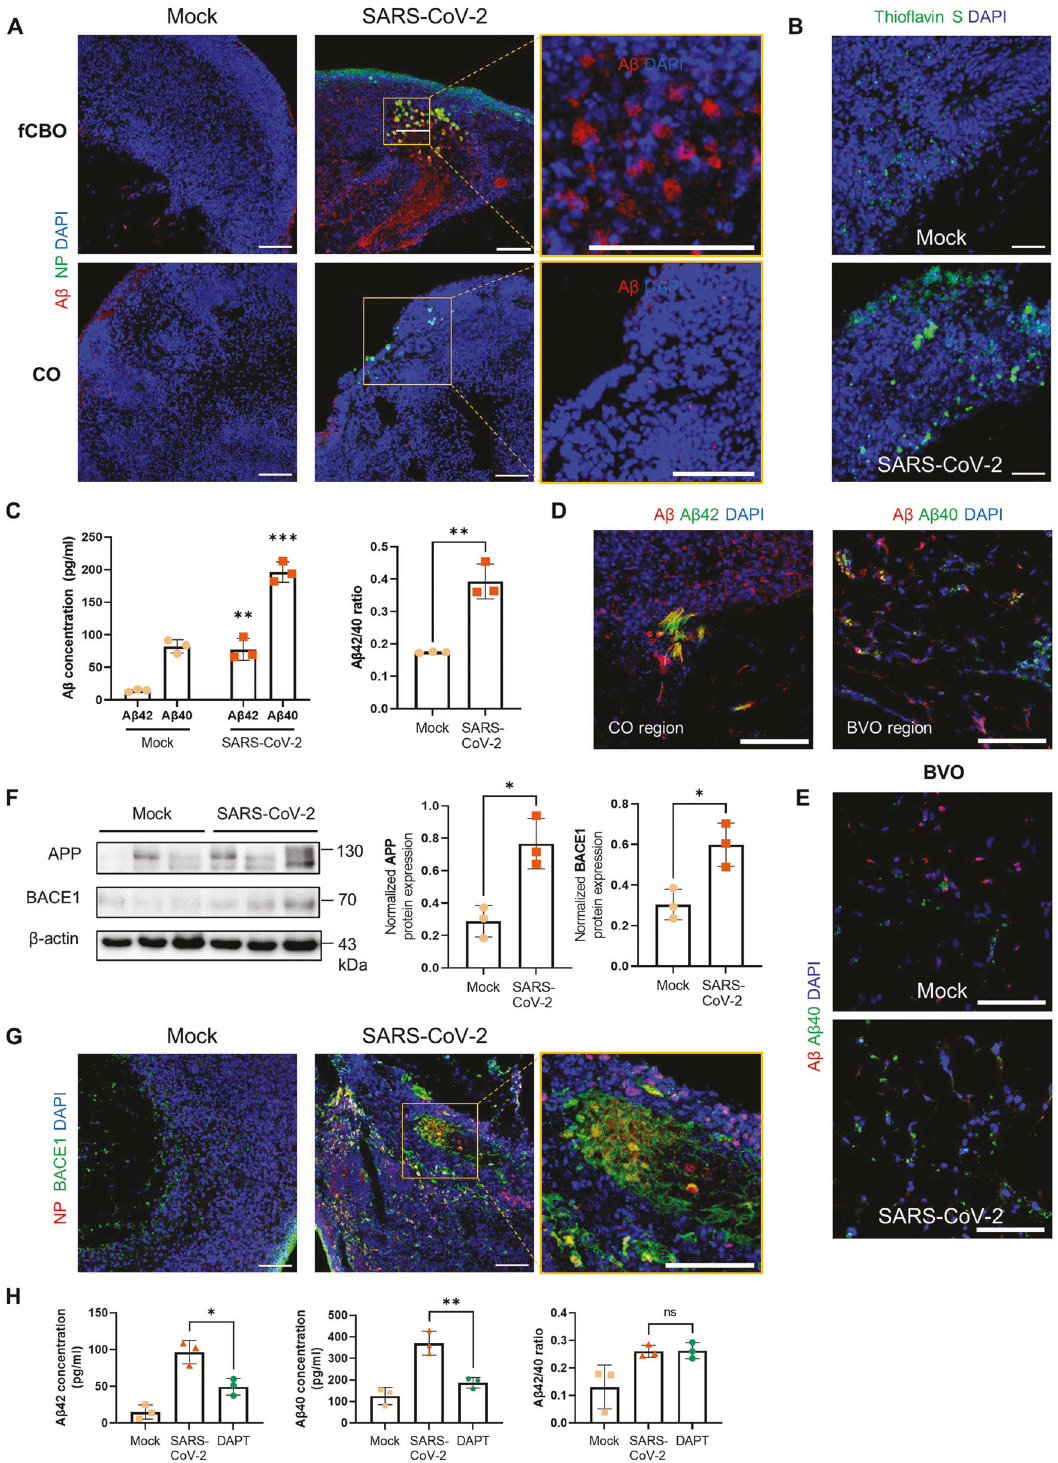
Fig. 5 SARS-CoV-2 infected fused cortical-blood vessel organoids expressed β -amyloid plaques. A Immunostaining of SARS-CoV-2 or mock infected fCBOs and COs for NP and A β . Scale bars = 100 μ m. B Thio fl avin-S staining of SARS-CoV-2 or mock infected fCBOs. Scale bars = 100 μ m. C Concentrations of A β 42 and A β 40 quanti fi ed by ELISA and A β peptide 42/40 ratios in fCBOs before and after SARS-CoV-2 infection ( n = 3). D Immunostaining of SARS-CoV-2 infected fCBOs for A β and 42-residue A β (A β 42) or 40-residue A β (A β 40). Cortical organoid region (left) and blood vessel organoid region (right). Scale bars = 100 μ m. E Immunostaining of SARS-CoV-2 or mock infected BVOs for A β and A β 40. Scale bars = 50 μ m. F Western blot for β -amyloid precursor protein (APP), β -secretase (BACE1) and the loading control β -actin of SARS-CoV-2 or mock infected fCBOs and relative protein levels. ( n = 3). G Immunostaining of SARS-CoV-2 or mock infected fCBOs for BACE1 and NP. Scale bars = 100 μ m. H Concentrations of A β 42 and A β 40 quanti fi ed by ELISA and A β peptide 42/40 ratios in mock control, SARS-CoV-2 infected and DAPT treated fCBOs ( n = 3). Values represent mean with individual data points plotted. Error bars are SEM of the mean. * p < 0.05, ** p < 0.01, *** p < 0.001 by unpaired two-sided t -test.